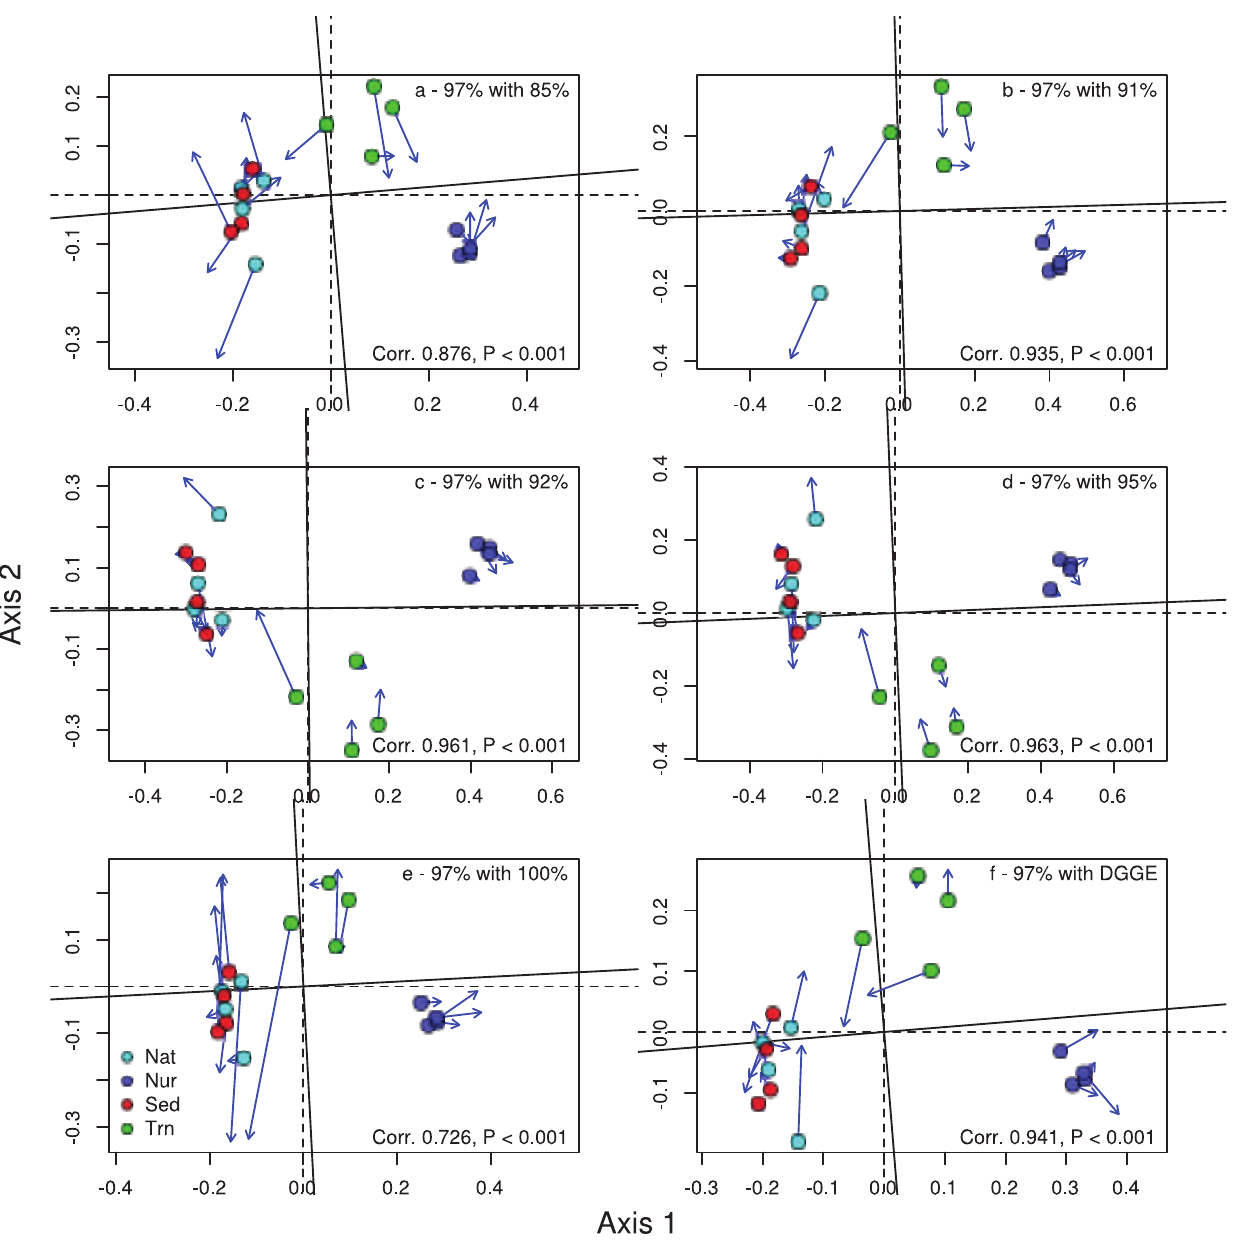
Figure 2. Ordination showing the first two PCO axes of the Alphaproteobacteria only analysis for a) 85% cut-off level with 97%, b) 91% cut-off level with 97%, c) 92% cut-off level with 97%, d) 95% cut-off level with 97%, e) 100% cut-off level and f) DGEE data with 97% cut-off level. The arrows in the ordination point to the target configuration, the actual symbols represent the rotated configuration, i.e., the ordination based on the 97% cut-off values. Correlation (Corr) and significance values are given in the lower right corner of each graph.